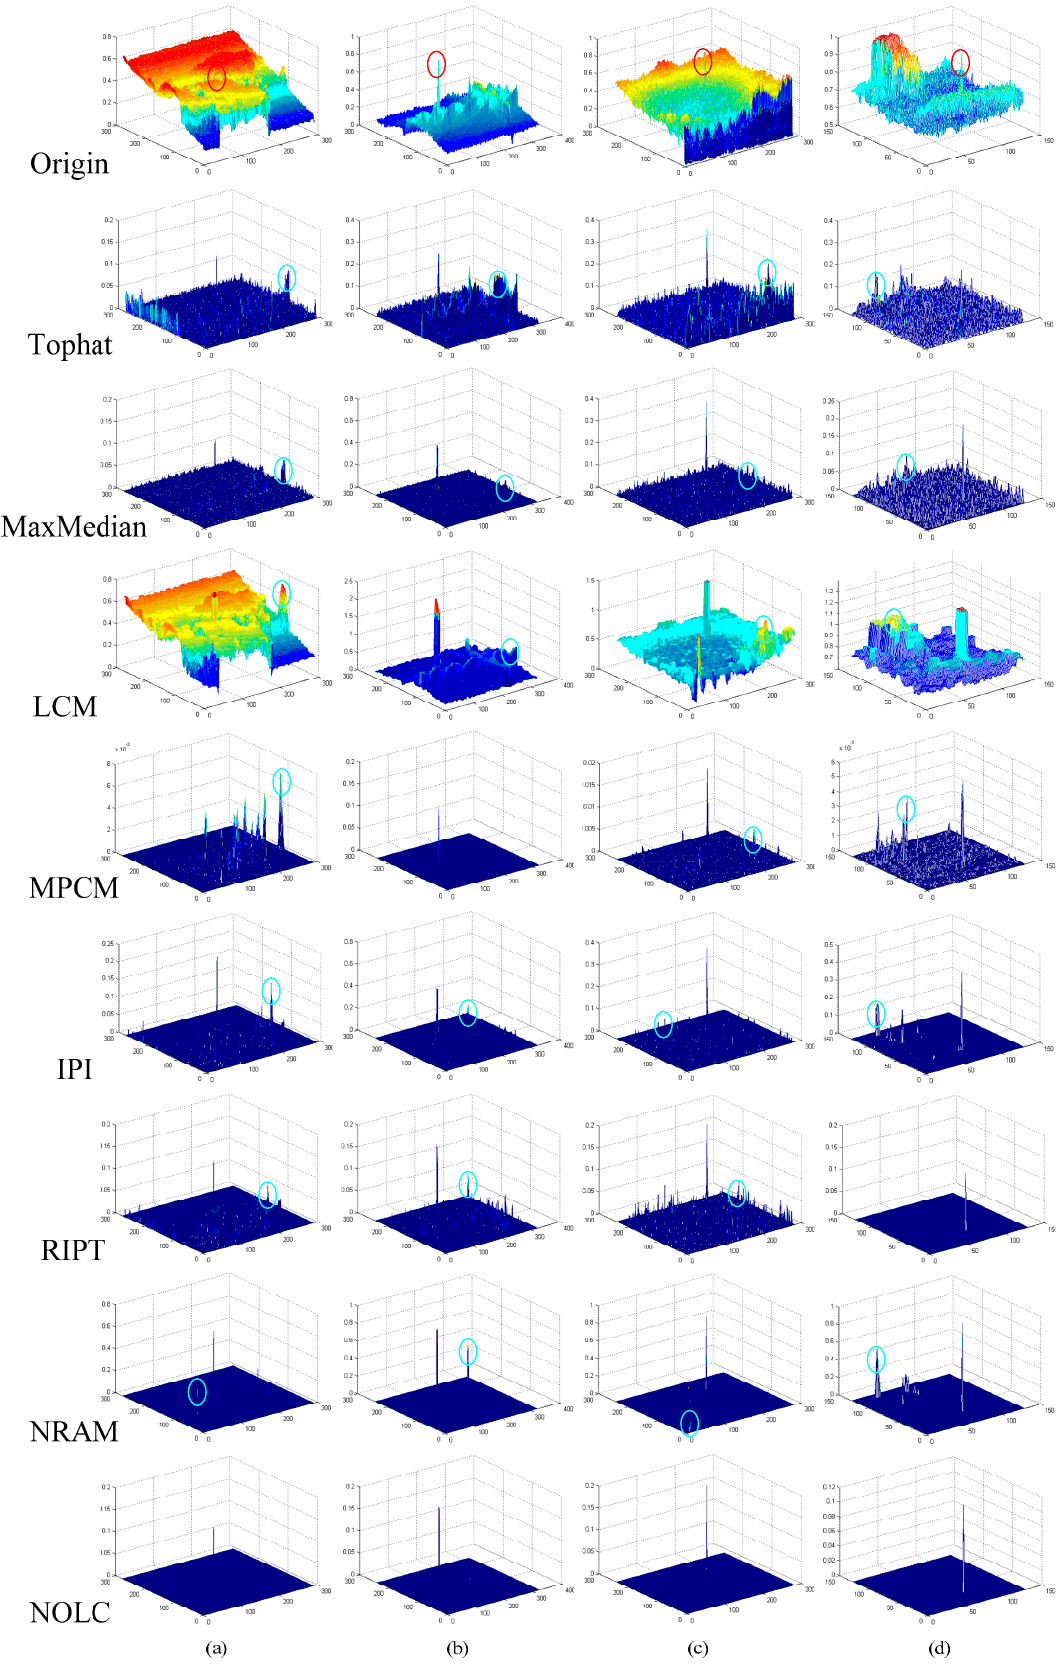
Figure 15. 3D display of Figure 14. (a)–(d) are scenes 1–4.